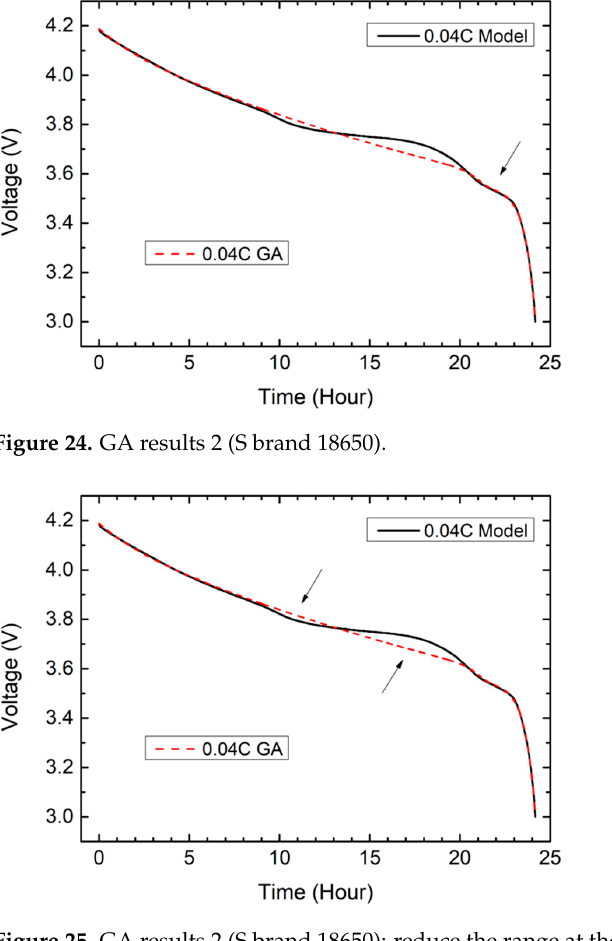
Figure 25. GA results 2 (S brand 18650): reduce the range at the arrow.